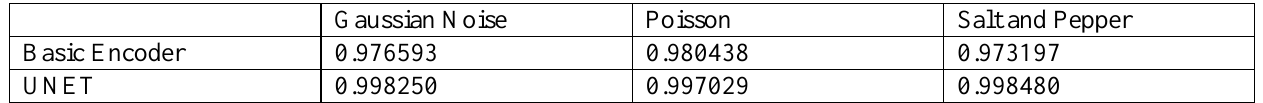
Table 3. Comparison SSIM value dealing with noise factor of